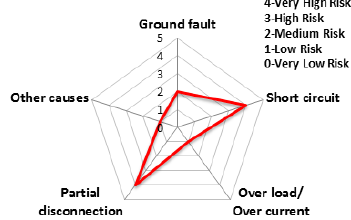
Figure 16. The risk rating for electrical fires in Incheon.